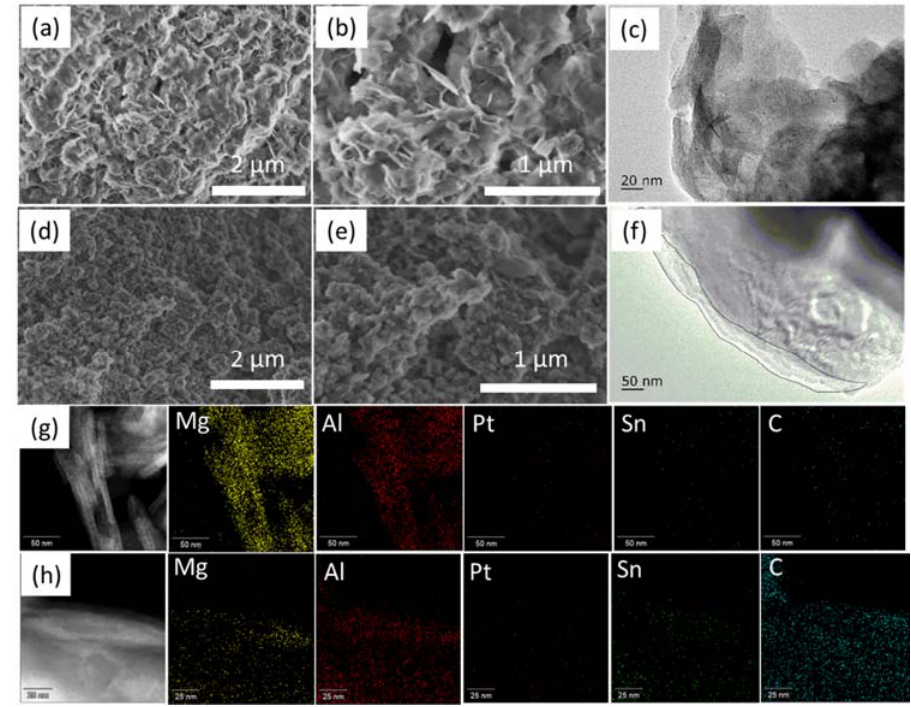
Figure 13. ( a , b ) SEM images and ( c ) TEM images of PtSn/Mg(Al)O ‐ 5 before the C 2 H 6 dehydrogenation reaction; ( d , e ) SEM images and ( f ) TEM images of PtSn/Mg(Al)O ‐ 5 after the C 2 H 6 dehydrogenation reaction; ( g , h ) energy dispersive X ‐ ray (EDX) lement mapping images of PtSn/Mg(Al)O ‐ 5 before and after C 2 H 6 dehydrogenation.